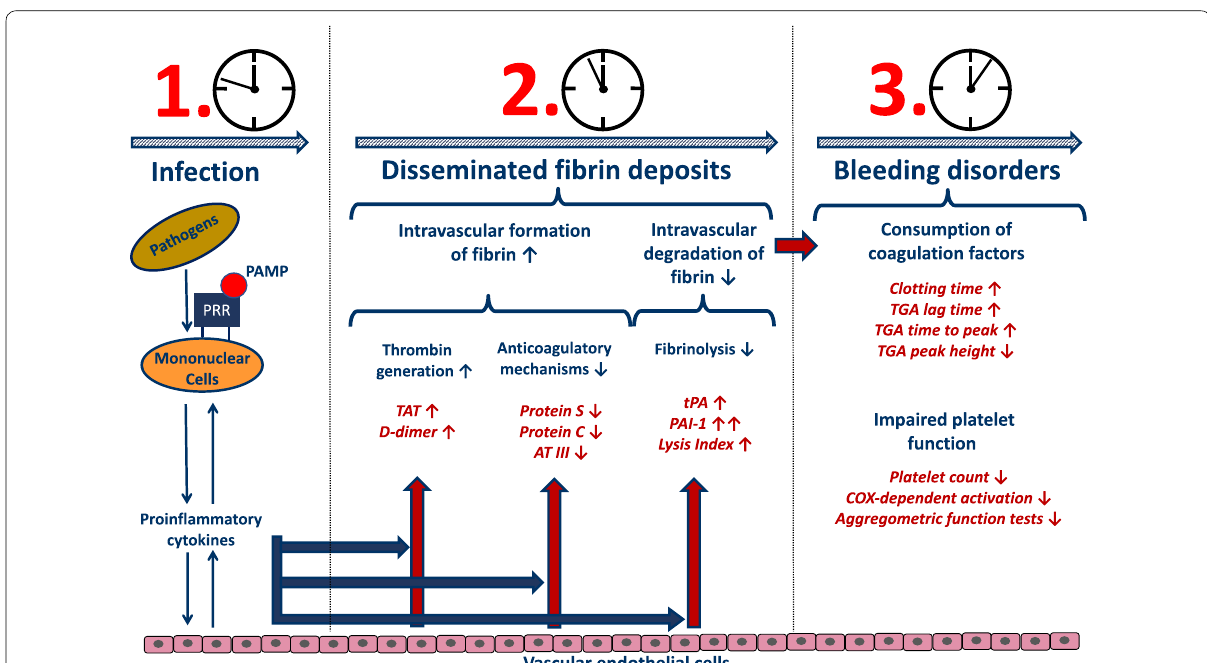
Fig. 6 This graphical summary clarifies the most important findings of the presented investigation within the context of septic